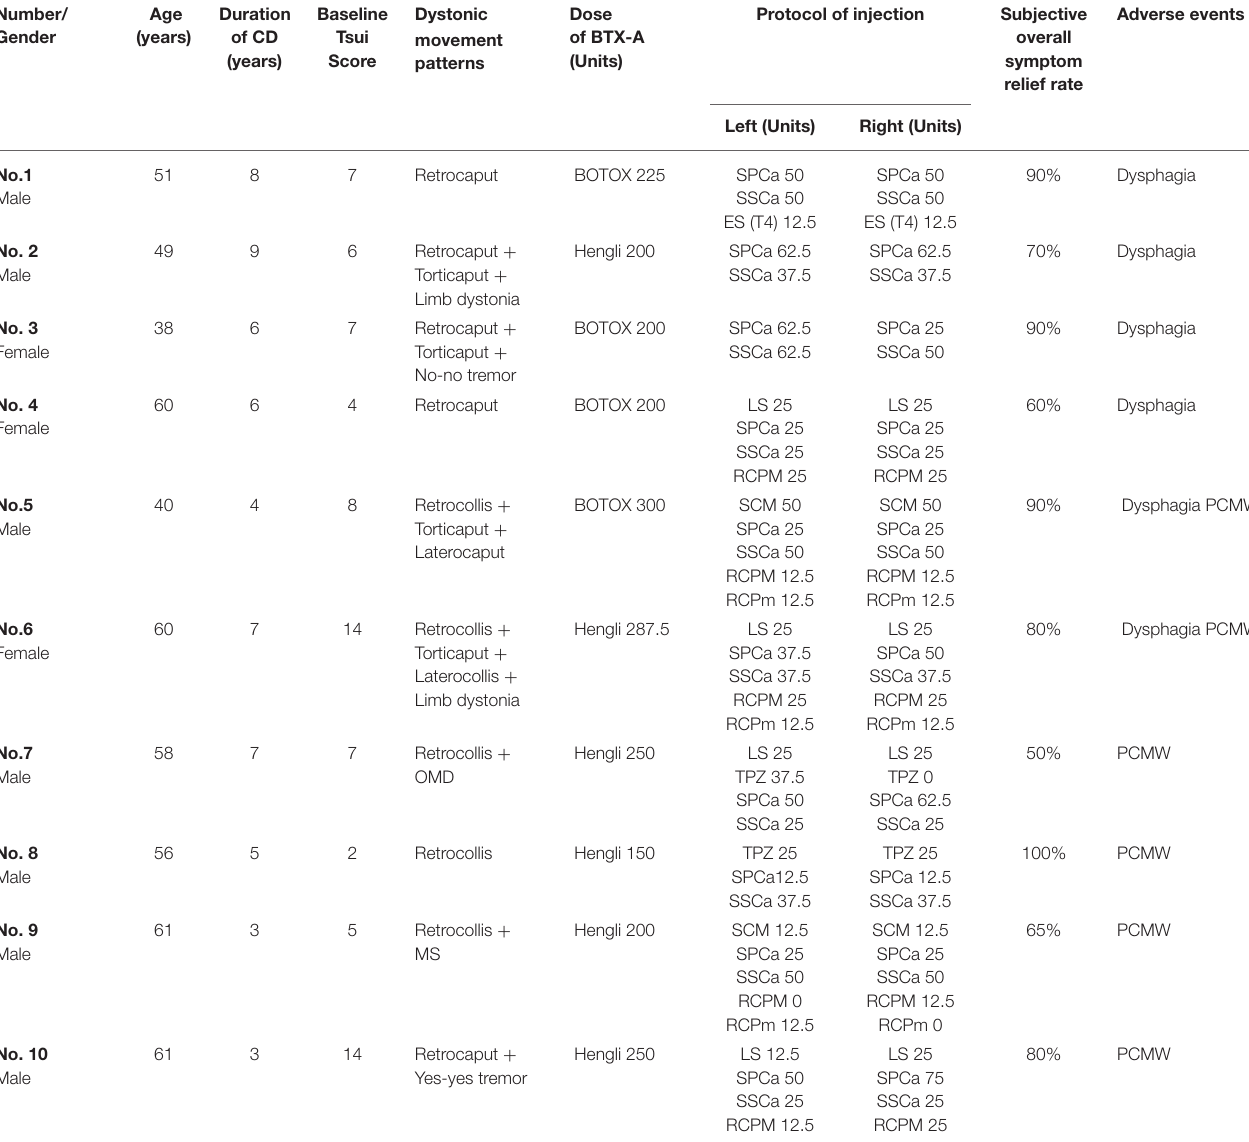
TABLE 3 | Clinical features of the 10 patients who showed adverse events. Number/ Gender movement